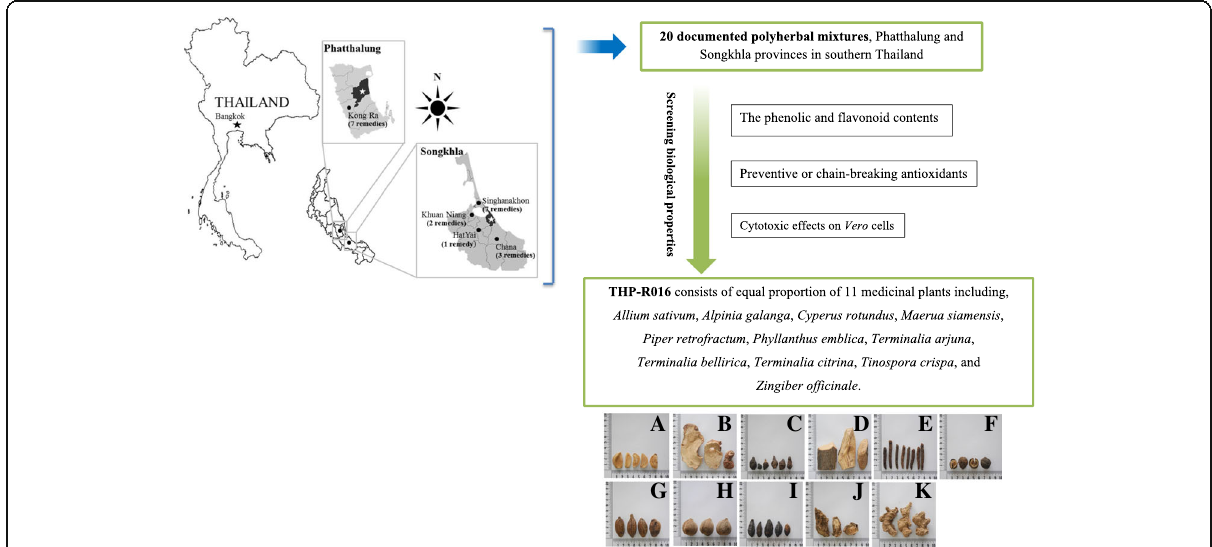
Fig. 1 Map showing the area that herbal remedies used in this study have been found (a blank map of Thailand and regions map of Thailand were taken from http://commons.wikimedia.org with modification),THP-R016 consists of equal proportion of 11 medicinal plants including, Allium sativum L. ( a ), Alpinia galanga (L.) Willd. ( b ), Cyperus rotundus L. ( c ), Maerua siamensis (Kurz) Pax ( d ), Piper retrofractum Vahl ( e ), Phyllanthus emblica L. ( f ), Terminalia arjuna (Roxb. Ex DC.) Wight & Arn. ( g ), Terminalia bellirica (Gaertn.) Roxb. ( h ), Terminalia citrina (Gaertn.) Roxb. ex Fleming ( i ), Tinospora crispa (L.), Hook. f. & Thomson ( j ), and Zingiber officinale Roscoe ( k